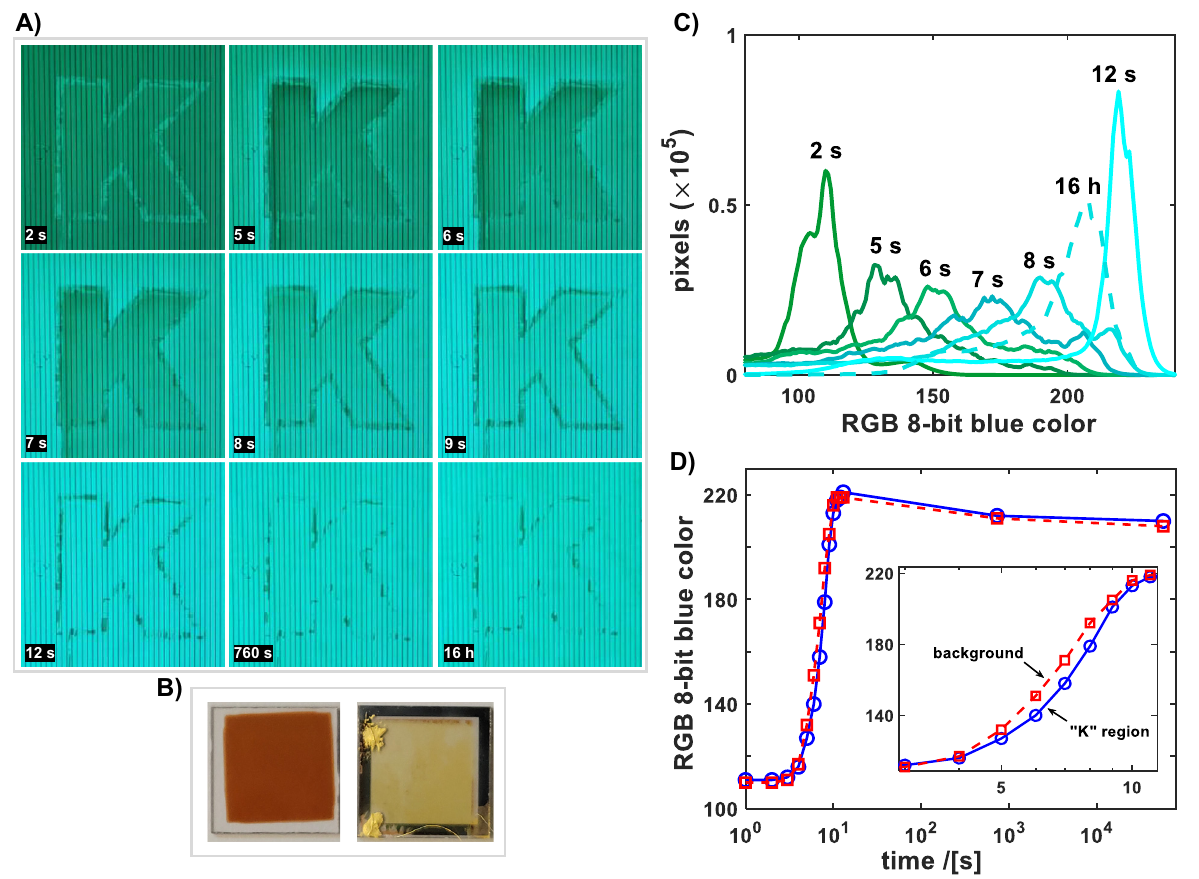
Figure 4: Patterned electrochemical switching